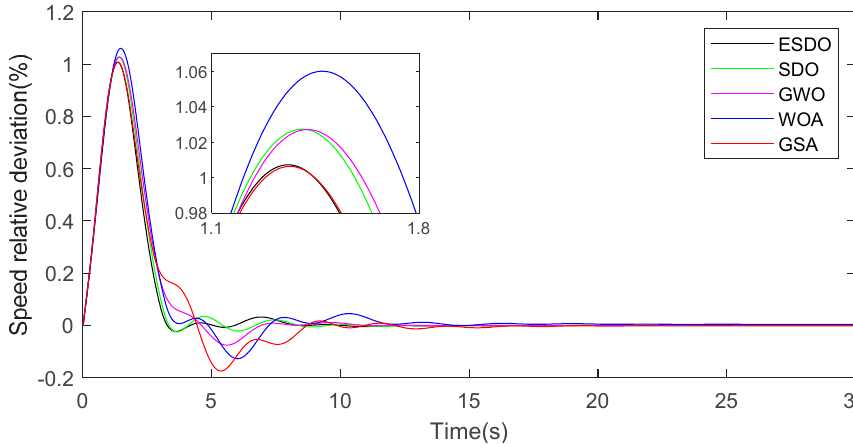
Figure 14. Speed response curves with 8% load.